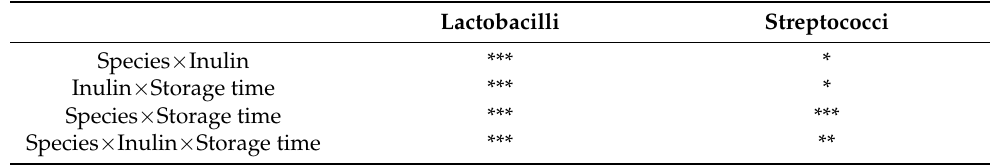
Table 8. Interactions between species, inulin addition and storage time observed in microbial counts of frozen